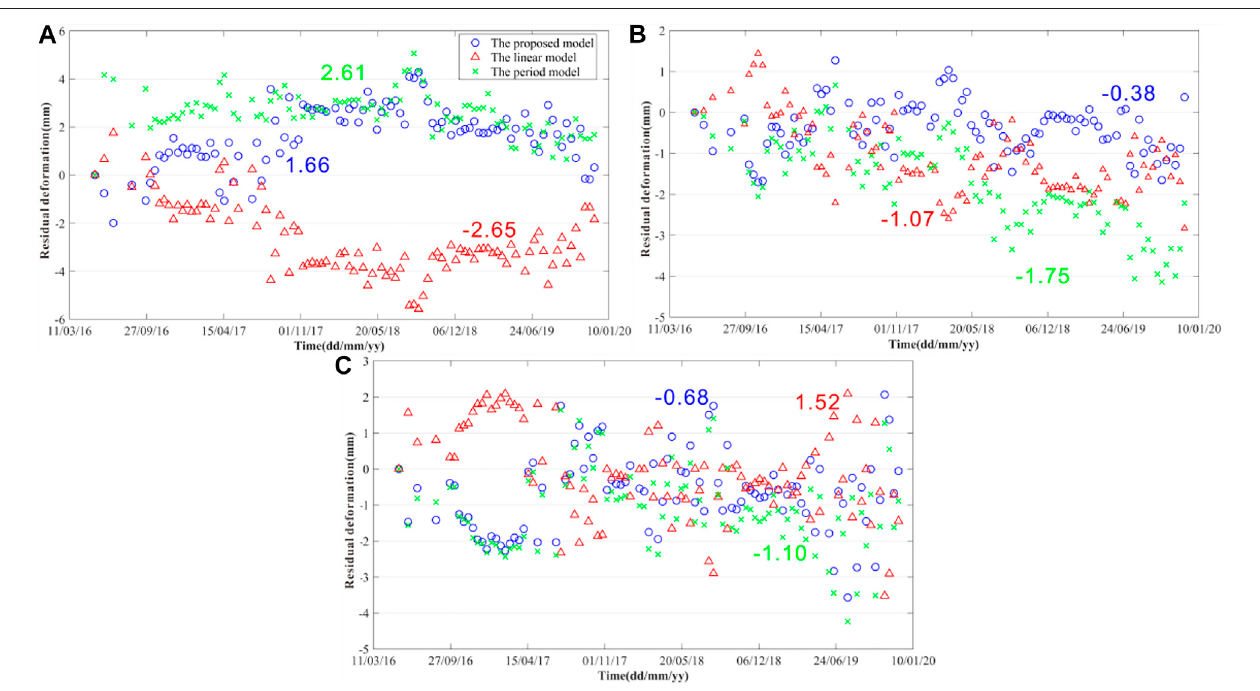
FIGURE 6 | Residual deformations of the three feature points retrieved from the proposed model (blue circle), linear model (red triangle), and period model (green cross). The color number represents the average value of the residual deformation of the corresponding model, respectively. (A) point f, (B) point a, and (C) point d.